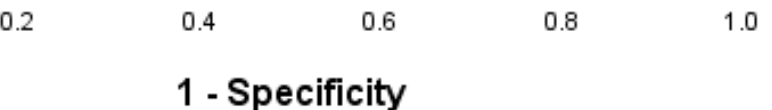
Figure 2. ROC curve of the multivariate logistic regression model for CAD progression; AUC was 0.739 (95% CI 0.660–0.818), p < 0.001. The dash line represent the line of no-discrimination.